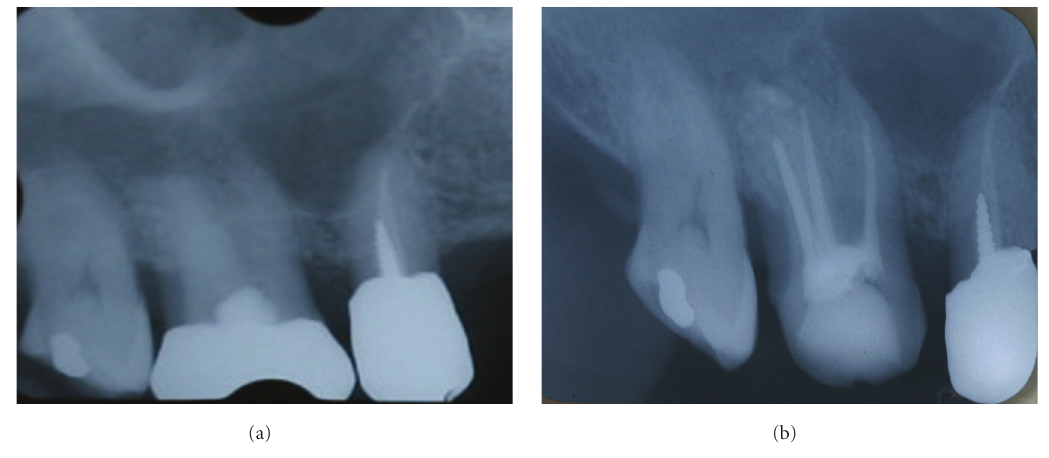
Figure 2: Radiography of tooth 16: (a) before treatment and (b) after root canal filling.